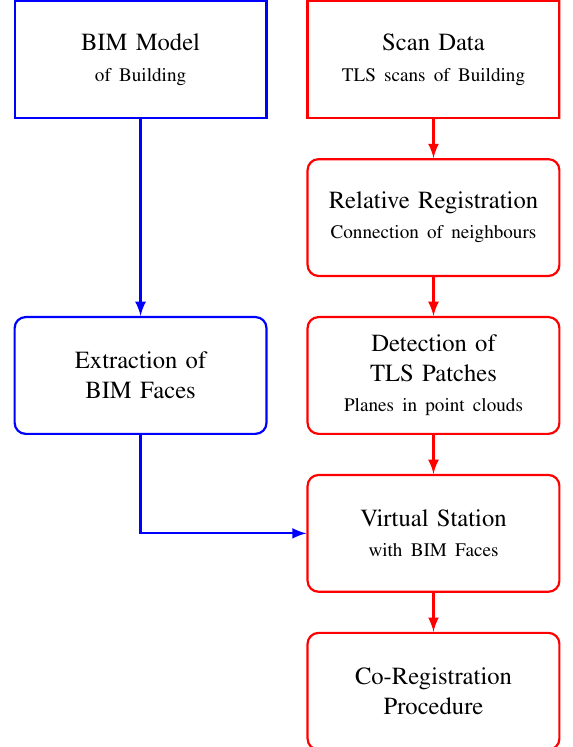
Figure 1. The co-registration starts with the local scan data (red) and the BIM model (blue). Several pre-processing steps are required to finally co-register the point cloud in the BIM model.